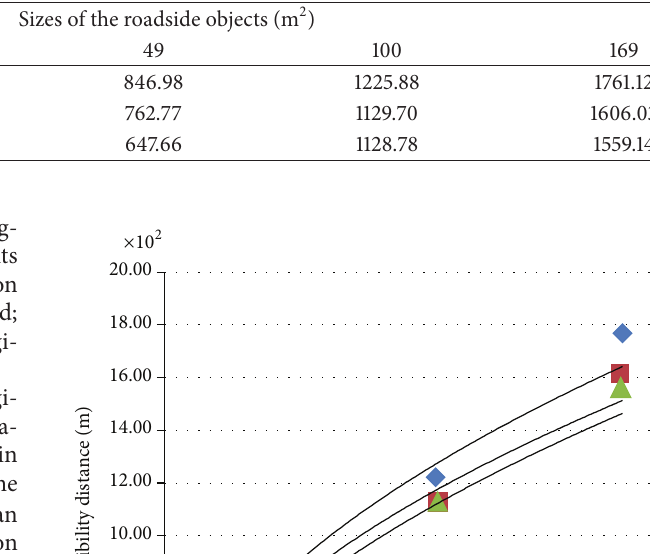
Table 2: The mean legibility distance under 60 km/h.